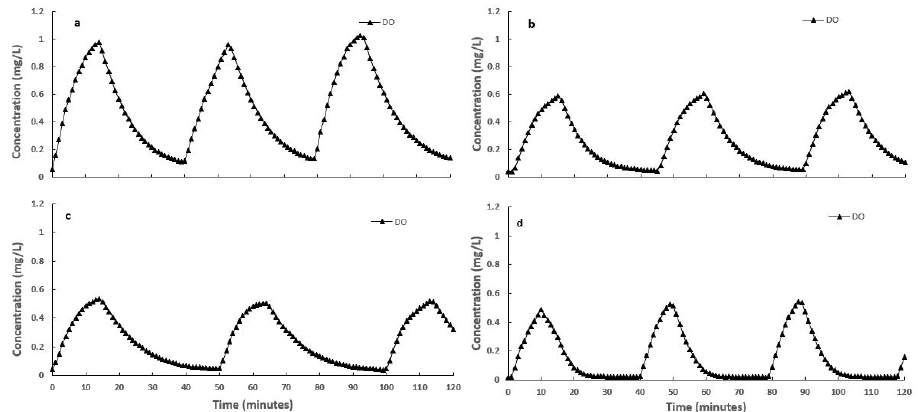
Figure 6. Different intermittent aeration cycle with DO profile: ( a ) Intermittent aeration cycle with cycle length 15 min ON/25 min OFF (IAC-1); ( b ) Intermittent aeration cycle with cycle length 15 min ON/30 min OFF (IAC-2); ( c ) Intermittent aeration cycle with cycle length 15 min ON/35 min OFF (IAC-3); ( d ) Intermittent aeration cycle with cycle length 10 min ON/30 min OFF (IAC-4).